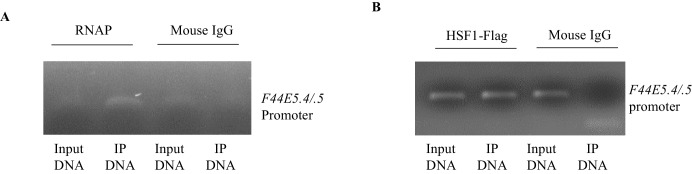
Validation of specificity and efficiency of antibodies used for ChIP assays.(A–B) Representative agarose gels used to assess specificity and efficiency of immunoprecipitation (IP) and primer sequences used for ChIP-PCR. All amplified bands were the expected size and mouse control IgG did not yield detectable signals. Most importantly, we confirmed that the ChIP signal in control animals was detectable and real, to validate the calculation of normalized fold changes in our experiments. (A) IP from wild-type control animals using mouse antibody to total RNAP. Mouse IgG used as control. Primers at the Promoter region of hsp70 (F44E5.4/.5). (B) IP from wild-type control animals using mouse anti-FLAG antibody. Mouse IgG used as control. Primers at the Promoter region of hsp70 (F44E5.4/.5).